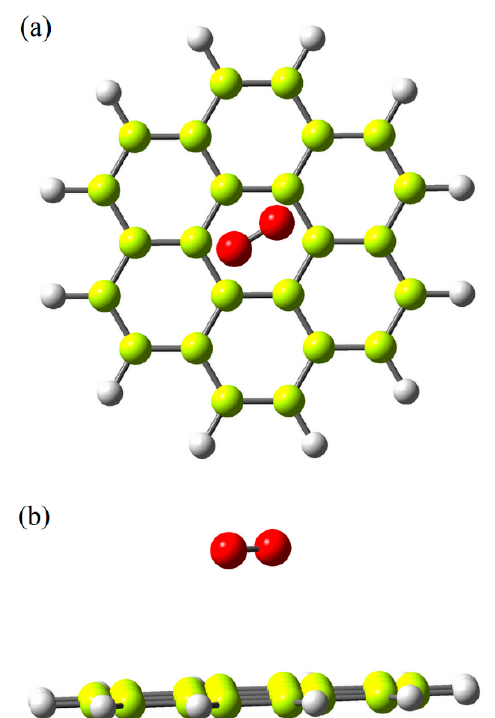
Figure 4. Side ( a ) and top ( b ) views of oxygen molecule adsorbed on pure graphene flake.